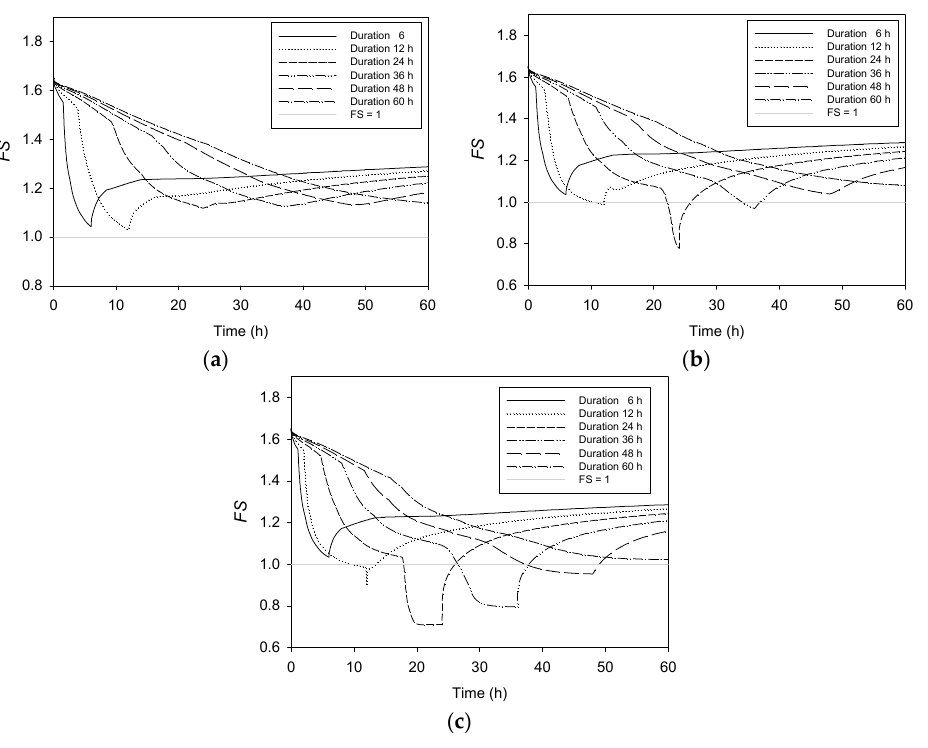
Figure 4. Factor of safety for various duration with uniform rainfall of: ( a ) 300 mm; ( b ) 400 mm; and ( c ) 500 mm.